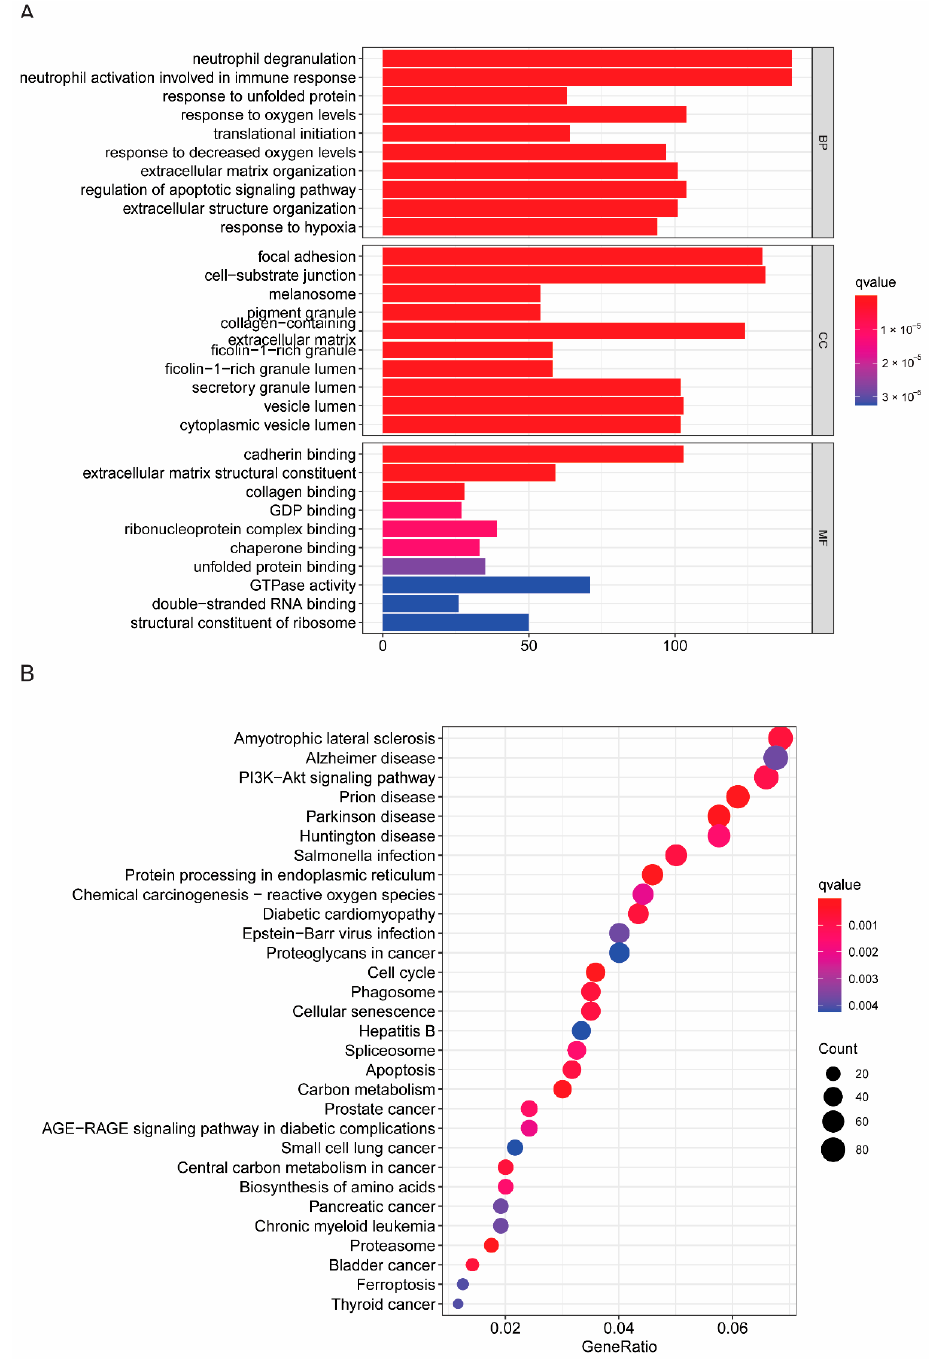
Figure 7. Molecular biological functional analysis based on the DEGs among the two ‐ risk groups in the TCGA cohort. ( A ) Bar plot for KEGG pathways. ( B ) Bubble plot for GO